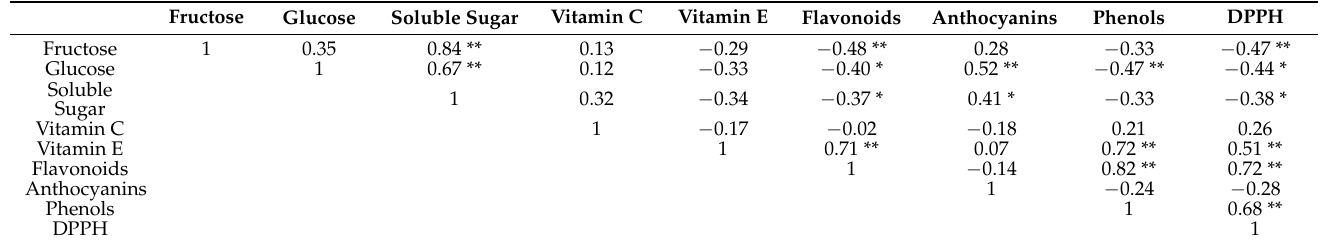
Table 4. Correlation of active substances and antioxidant